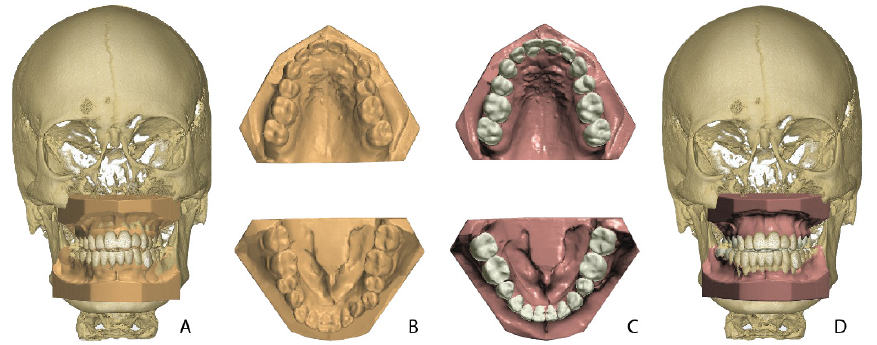
Figure 1. Overview of models in the setup fabrication process. ( A ) Pre-treatment dental model in CBCT. ( B ) Pre-treatment model. ( C ) Orthodontic setup. ( D ) Orthodontic model in CBCT.